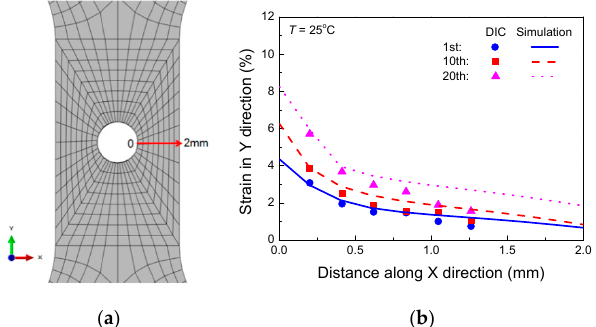
Figure 13. Comparison between the simulated results and measured ones by the DIC technology: ( a ) evaluated path location; ( b ) curves of strain in Y direction versus distance along X direction at different temperatures.